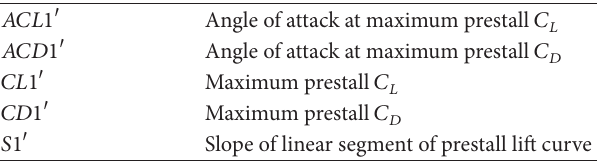
Table 4: AERODAS input parameters that need to be adjusted for finite aspect ratio. The prime notation means that the parameters are for an infinite aspect ratio airfoil; without it, they would be for a finite aspect ratio